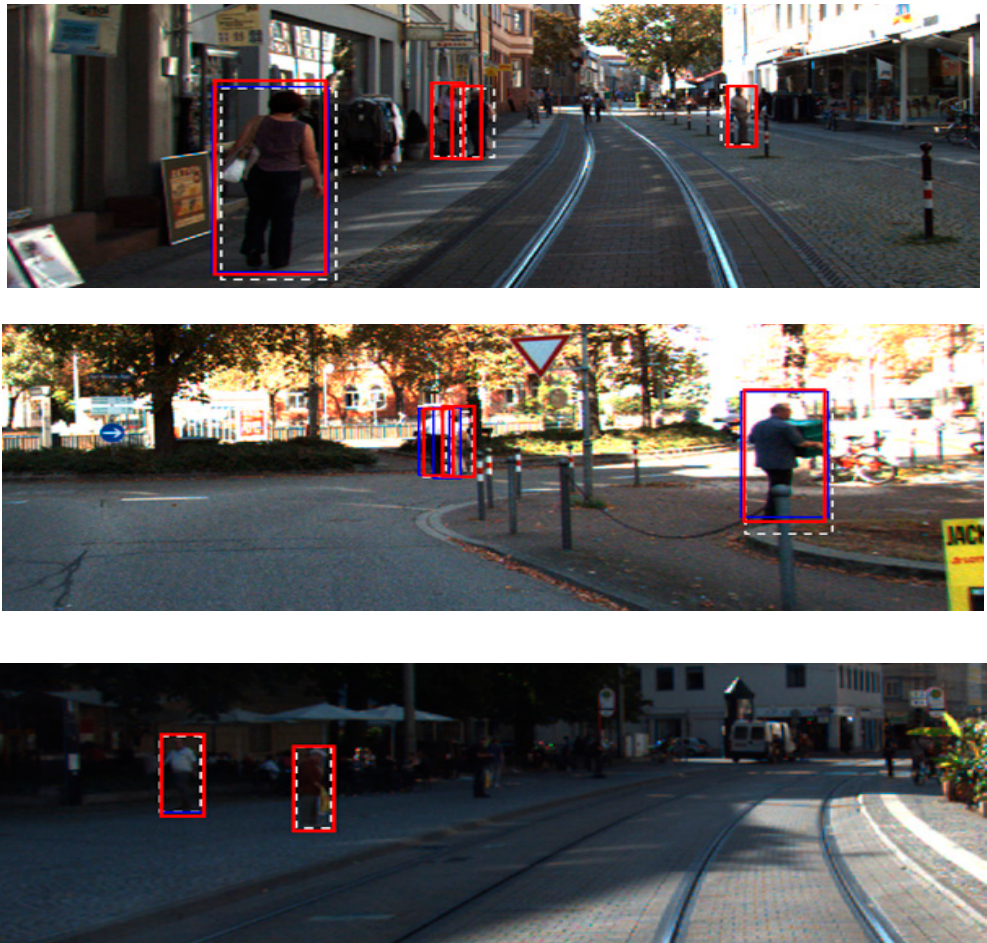
Figure 9. Comparison of pedestrian detection examples with Y-CM and MYs-WM.